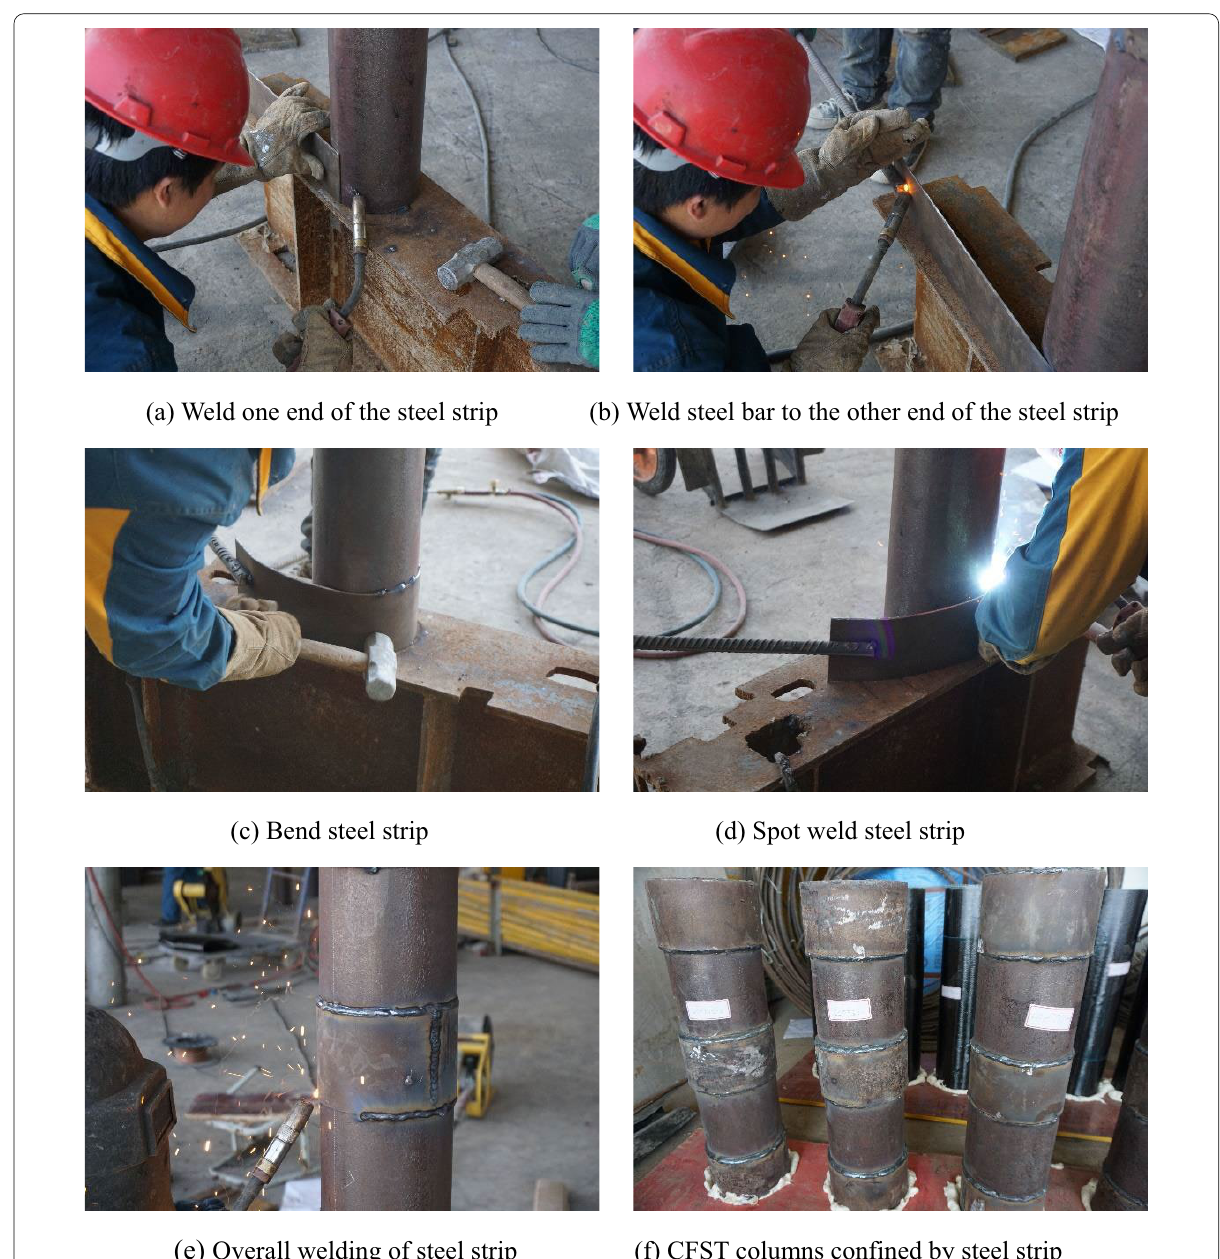
Fig. 5 Production process of welded steel strip-strengthened CFST